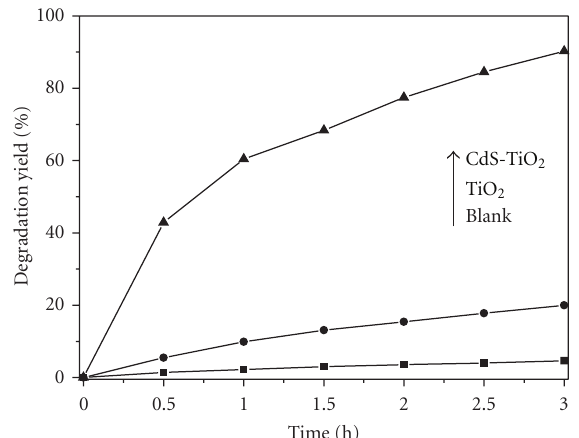
Figure 5: Photocatalytic degradation of RhB with CdS-TiO 2 and TiO 2 samples and without catalyst (blank) under visible-light irra- diations,